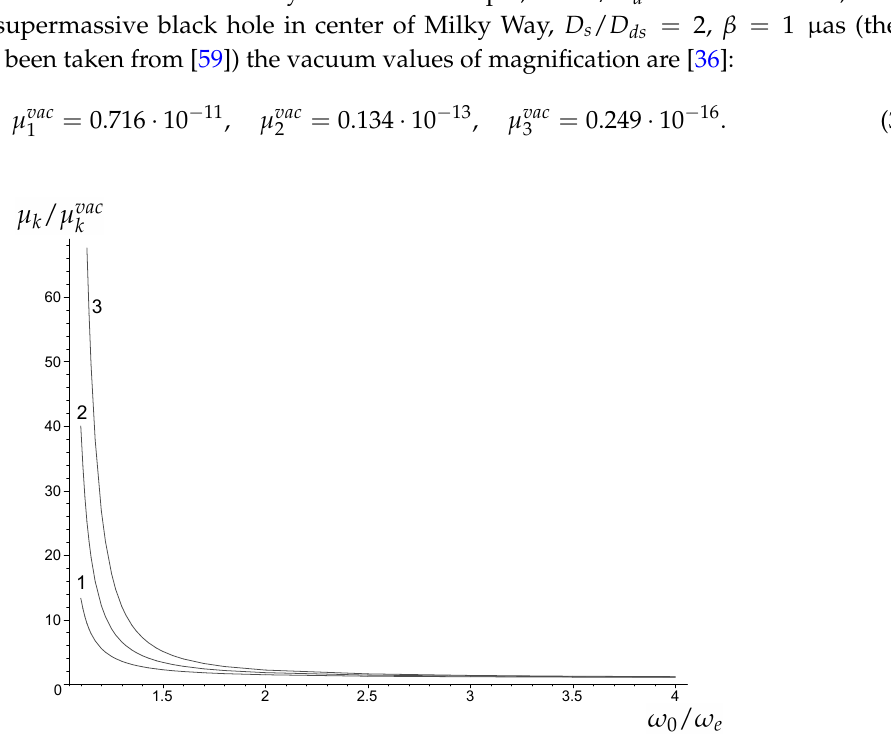
Figure 8. Comparison of the magnification factors of relativistic images for lensing in homogeneous plasma and in vacuum. Ratios µ k / µ vac are plotted as a function of ω 0 / ω e , for k = 1,2,3. Here µ vac k the vacuum value of magnification. Values µ k and µ vac depend on D s , D d , D ds , β , ω 0 / ω e , but ratio k µ k / µ vac depends only on ω 0 / ω e k